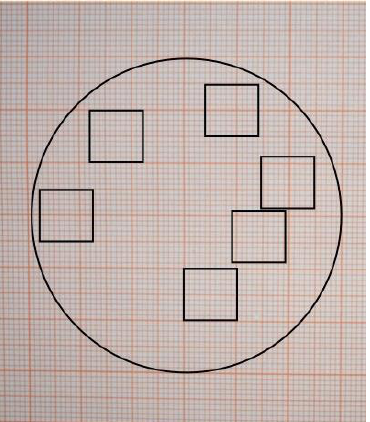
Figure 4. Grids used to count seeds and seedlings.